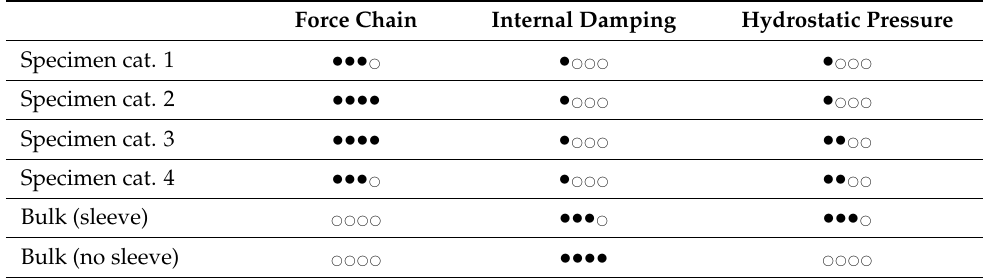
Table 3. Qualitative evaluation of effects of the damping mechanism on the GDE damping performance. Force Chain Internal Damping Hydrostatic Pressure Specimen cat.